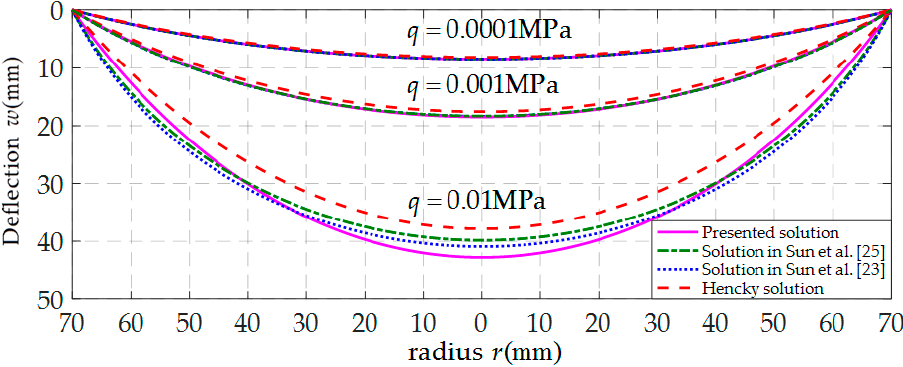
Figure 9. Variation of w with r .